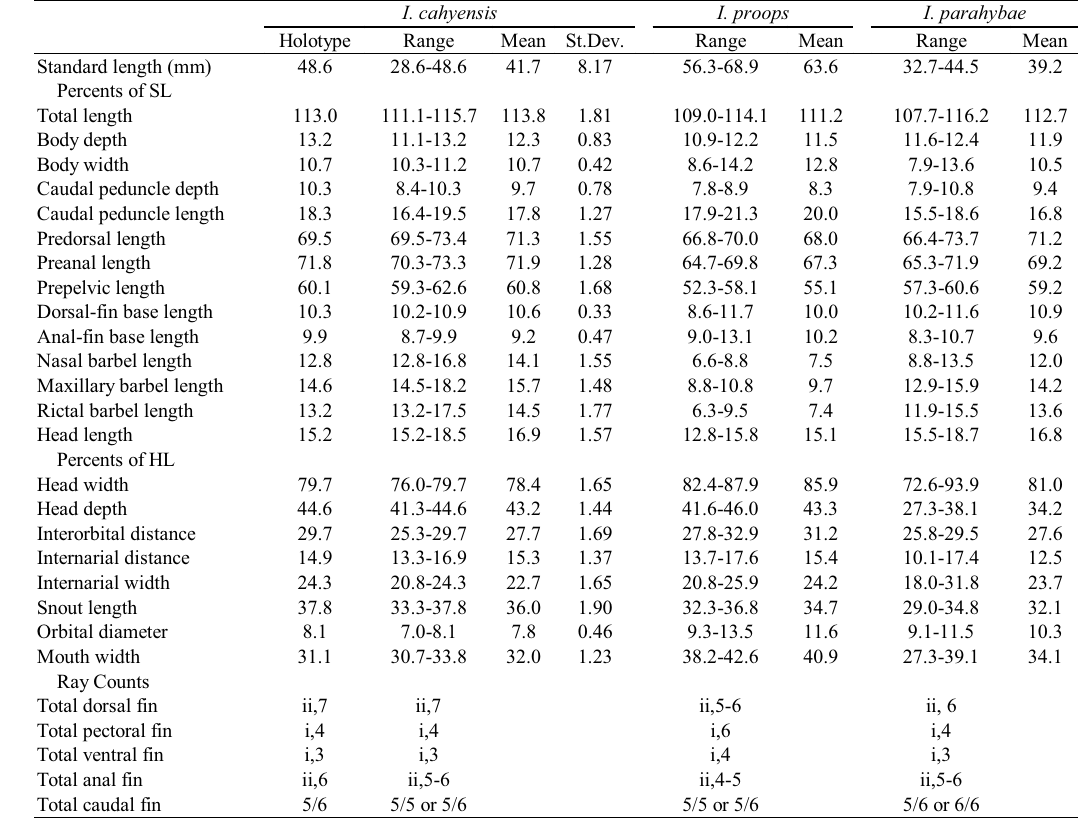
Table 2. Morphometric and meristic data for Ituglanis cahyensis (holotype MNRJ 28404; n=5), I. proops (n=8) and I. parahy- bae (n=6). Meristic data for I. parahybae also include MNRJ 782